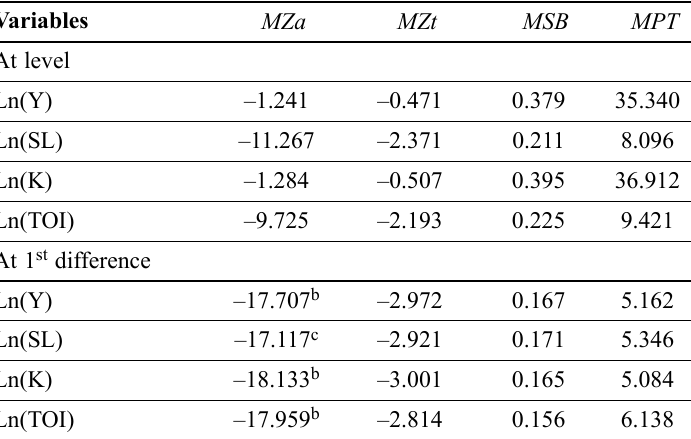
Table 2. Unit root test